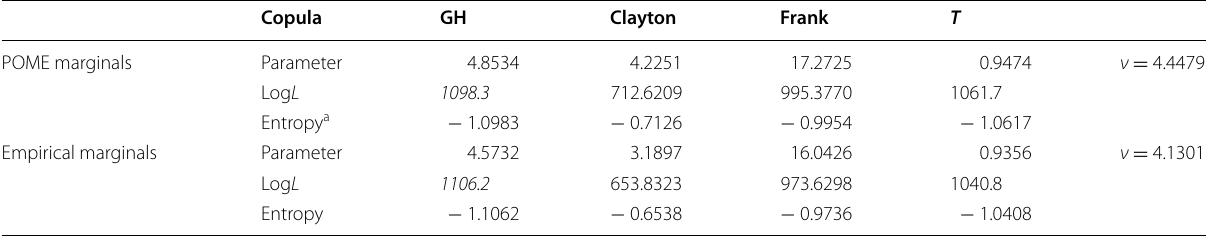
Table 4 Parameters, Log L , and entropy estimated from parametric copula Copula GH POME marginals